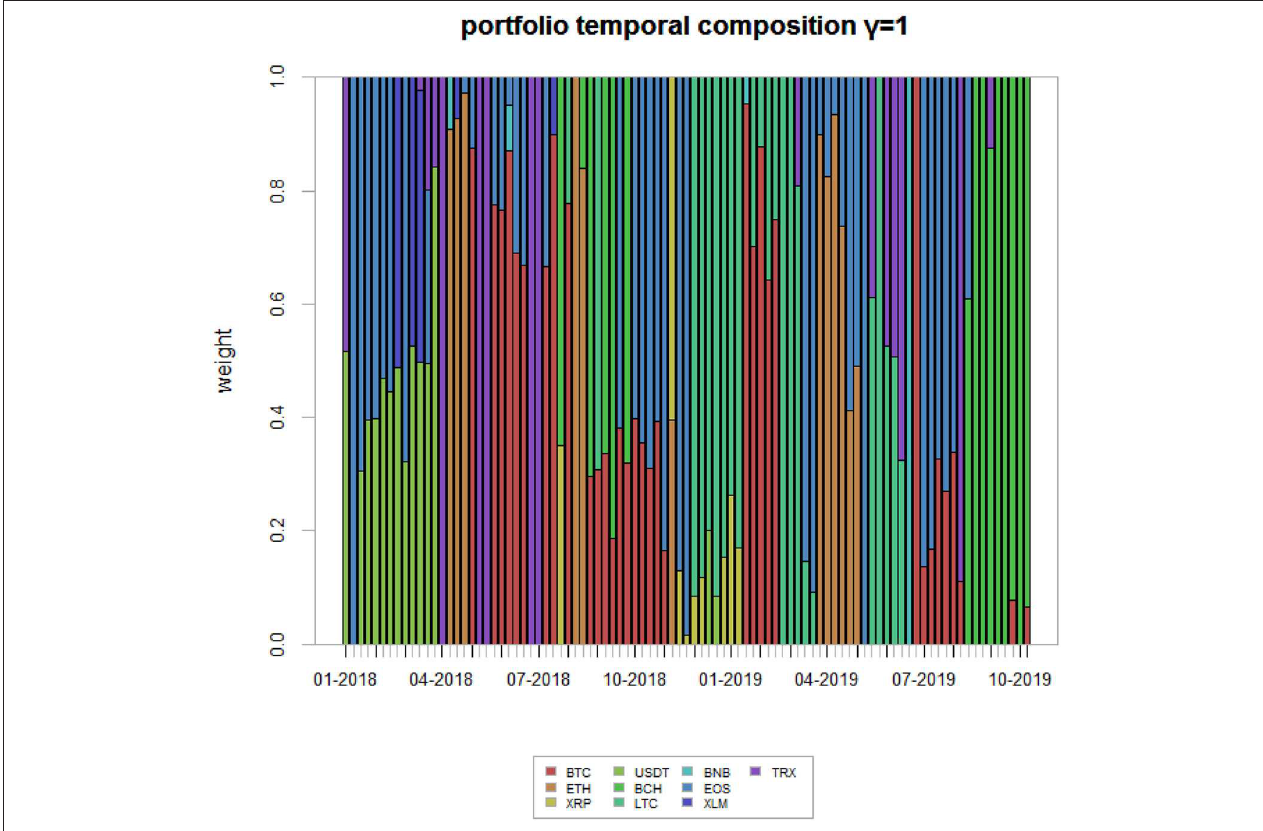
FIGURE 9 | Highly risk adverse strategy portfolio weights. This figure shows the portfolio weights associated to a highly systemic risk adverse strategy— γ = 1—for the analyzed time